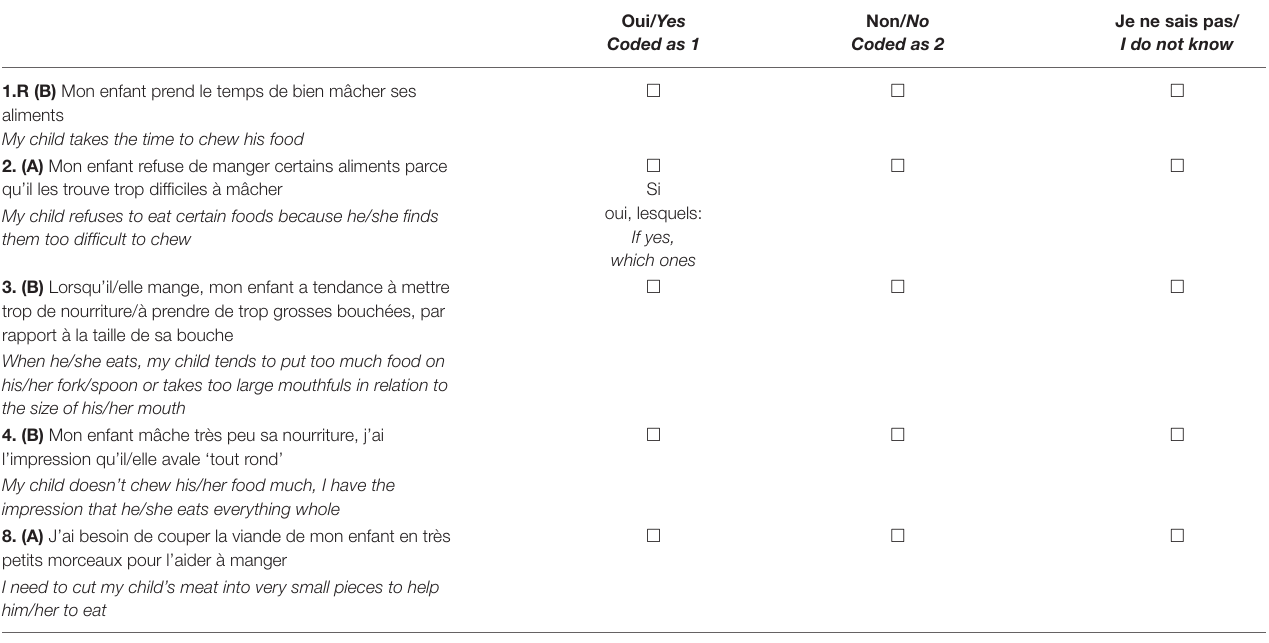
TABLE 2 | Parental questionnaire to evaluate their child’s chewing difficulty and chewing behavior traits.